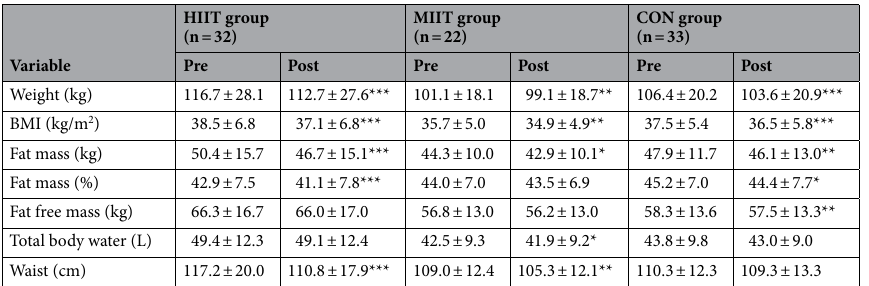
Table 2. Anthropometric and body composition data pre and post-intervention. Values are expressed as mean ± SD. HIIT high-intensity interval training group, MIIT moderate-intensity interval training group, CON control group, BMI body mass index. *( p < 0.05), **( p < 0.01), ***( p < 0.001), significantly different from pre- intervention.